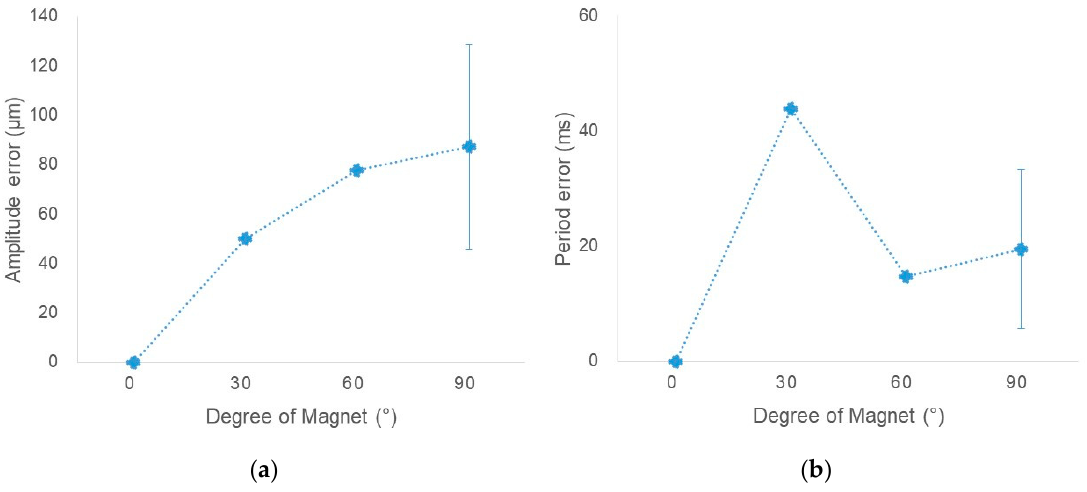
Figure 6. Error in ( a ) amplitude (ms) and ( b ) period ( μ m) by magnet position of 0°, 30°, 60°, and 90°.